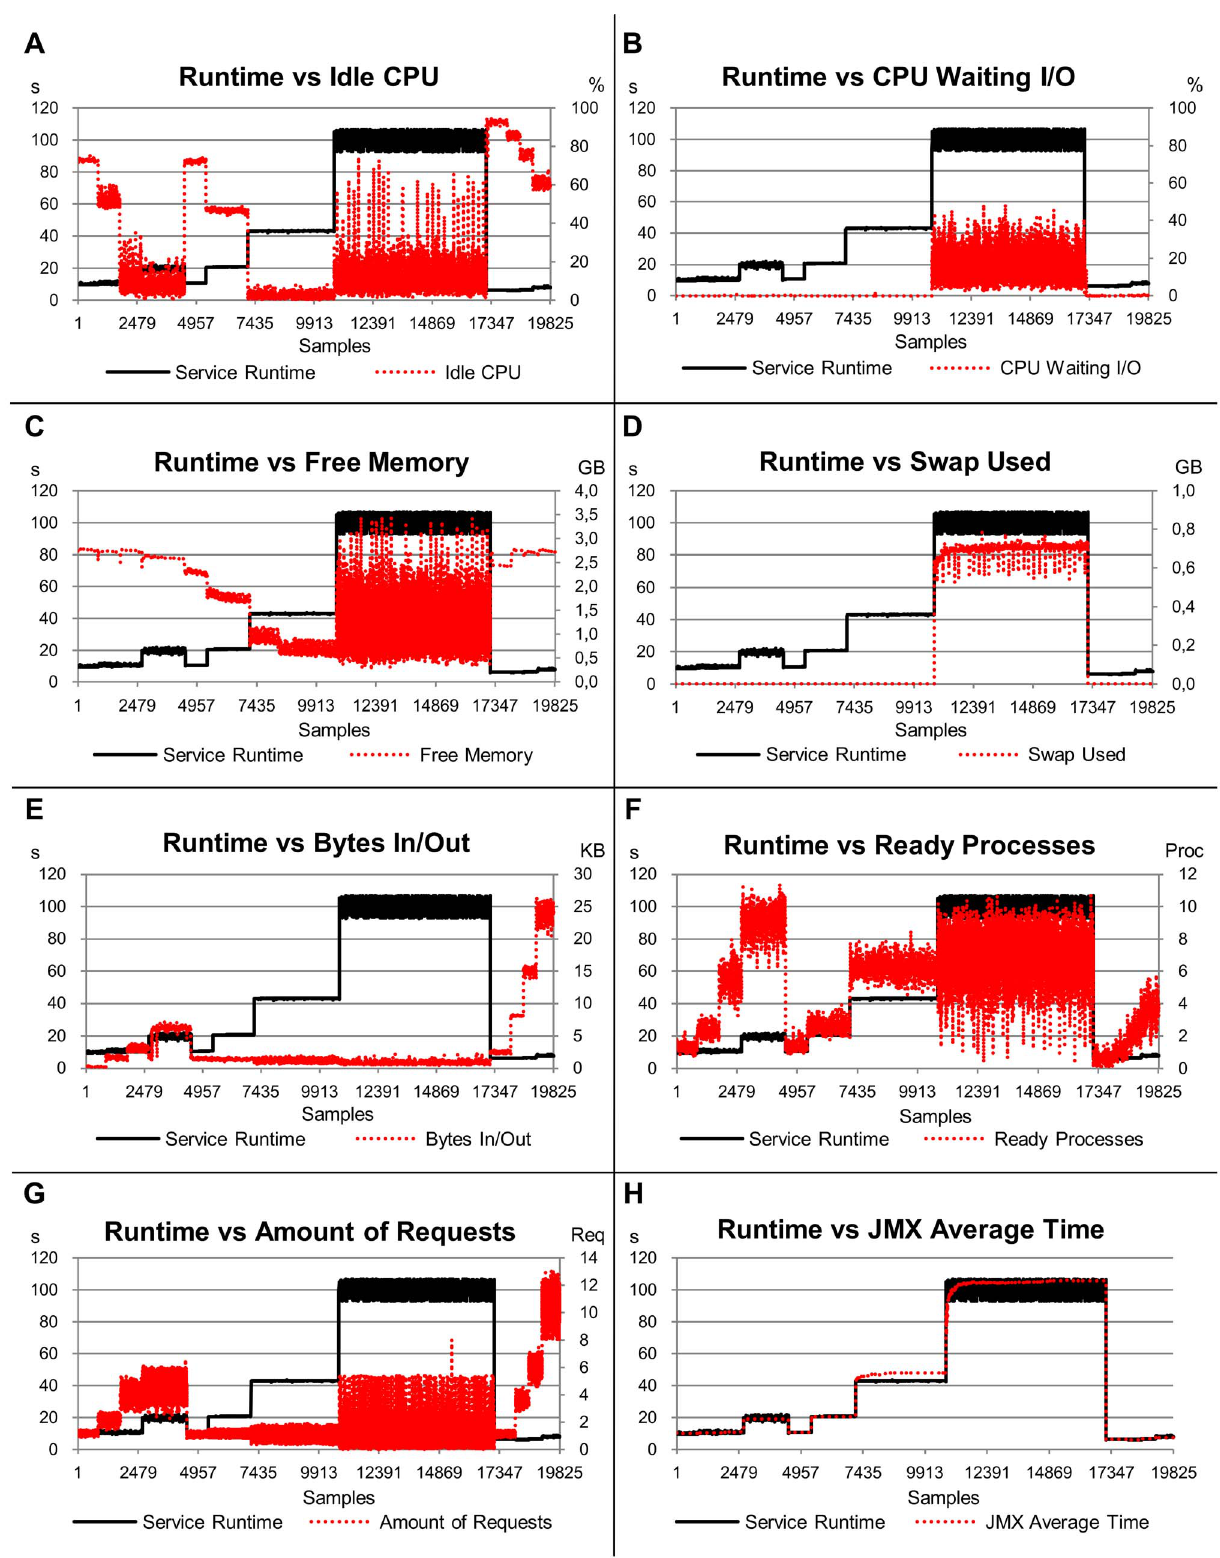
Figure 6. Relation of the service runtime versus eight load indices, considering the fourth scenario (all services). The left-hand scale of the y-axis always represents the service runtimes in seconds (s). The right-hand scale of the y-axis, where necessary, represents the metric used by the load index. The x-axis represents the samples collected every 10 s by Ganglia and JMX while the benchmarks were requesting services for the server.